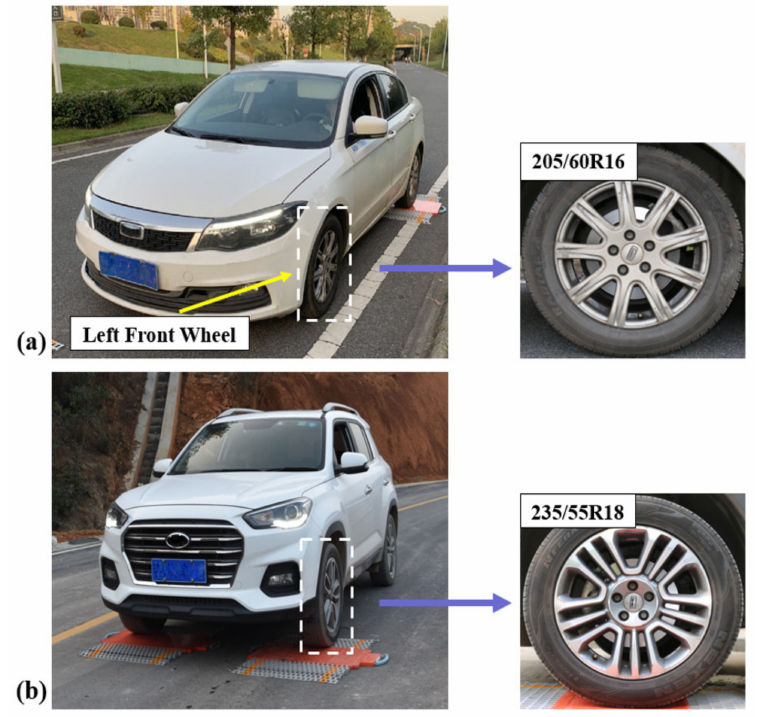
Figure 18. Tested passenger cars and tires: ( a ) sedan; ( b ) SUV. The inflation pressure and vertical deflection of each tire, and the actual weight of each axle were measured as shown in Table 5. The axle weights estimated by the oval equation (i.e., Equation (5)) and the modified equation (i.e., Equation (9)) are also